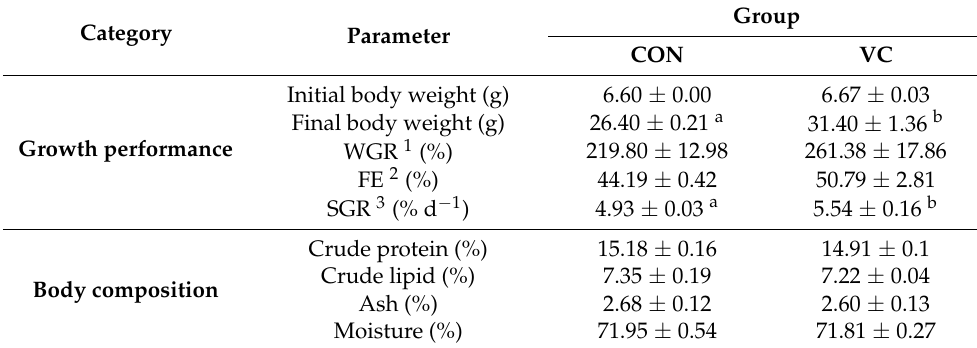
Table 3. Effects of dietary VC on growth performance and body composition of gibel carp.